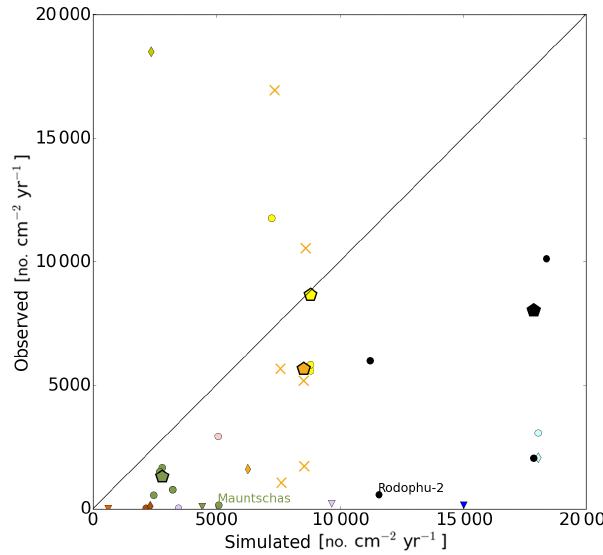
Figure 4. The same as Fig. 3 but on a linear scale with different axis limits (corresponding to the red frame in Fig.